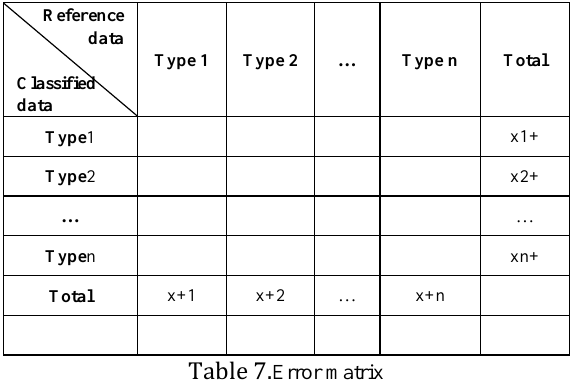
Table 7. Error matrix